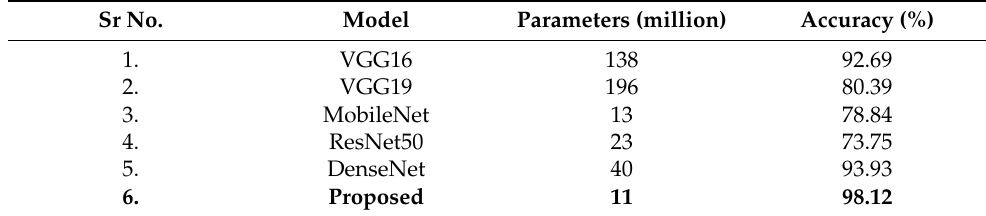
Table 4. Assessment of the suggested approach compared to other DL models. Sr